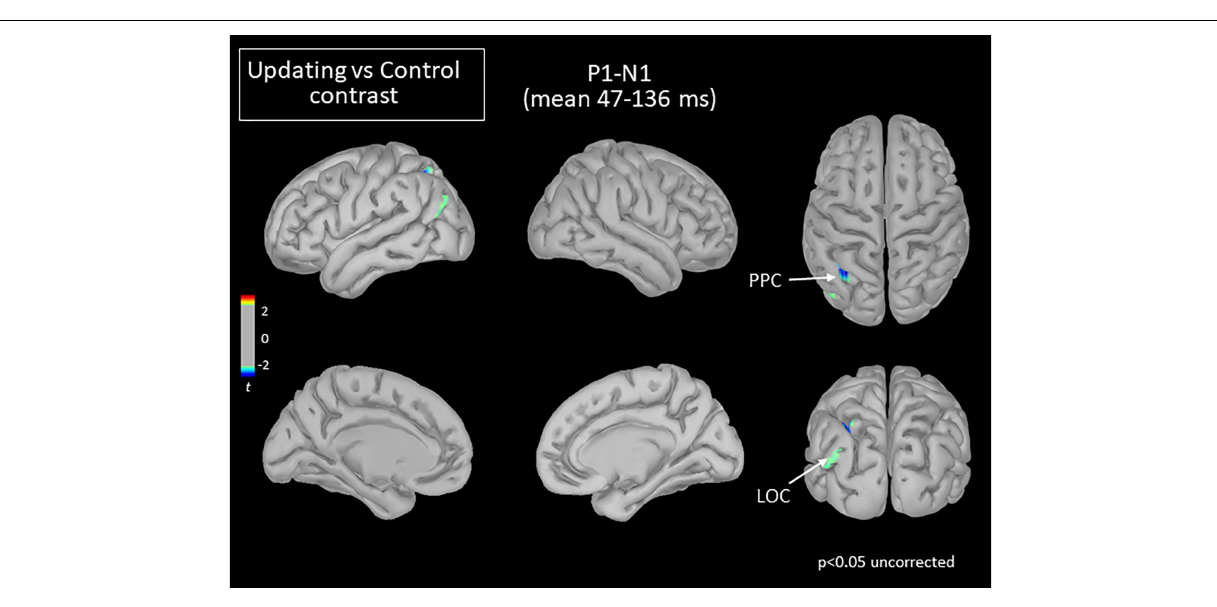
( p = 0.60). The interaction Task × rotation Amplitude was